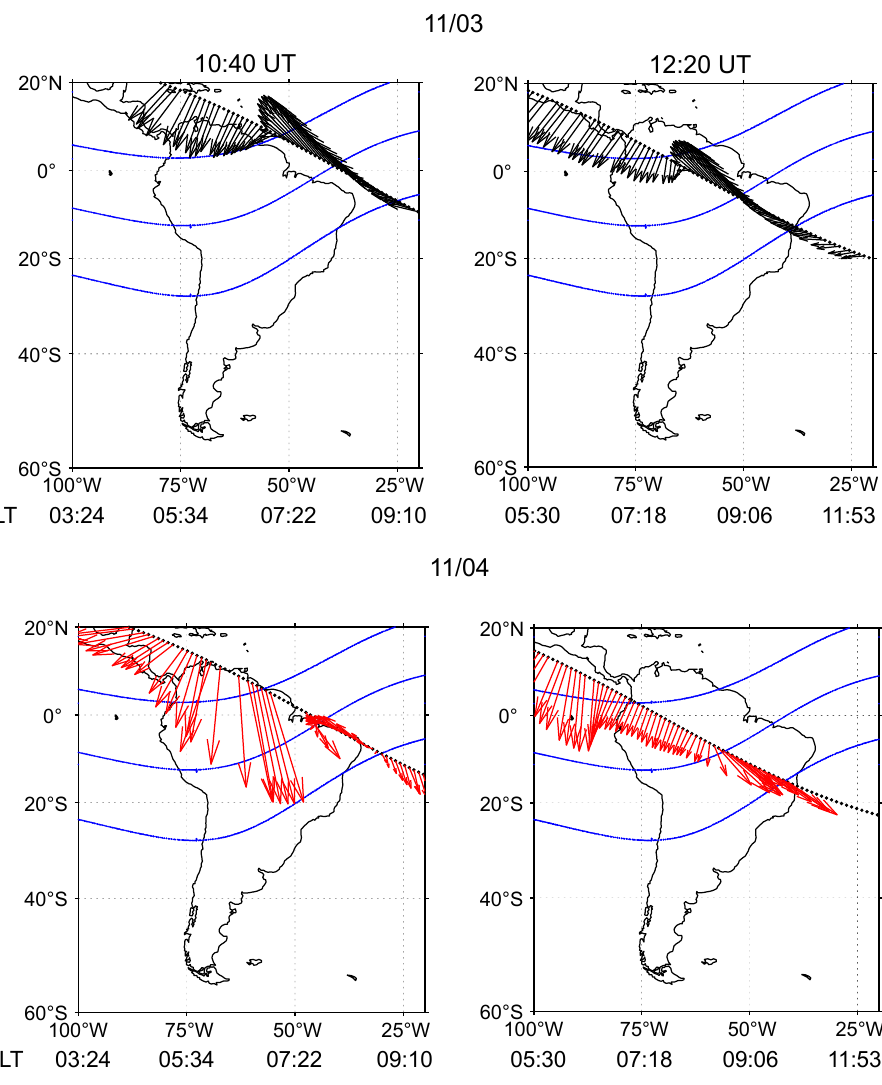
Figure 8. Comparison of ICON ion horizontal velocity between the quiet day (3 November; black arrows) and storm day (4 November; red arrows) around 10:40 UT and 12:20 UT. The black dots are satellite trajectories. Magnetic equator and magnetic latitudes of 15° on both sides are indicated by blue lines. The second row of the X-axis denotes the local time at which the ICON satellite passed the longitudes in the first row of